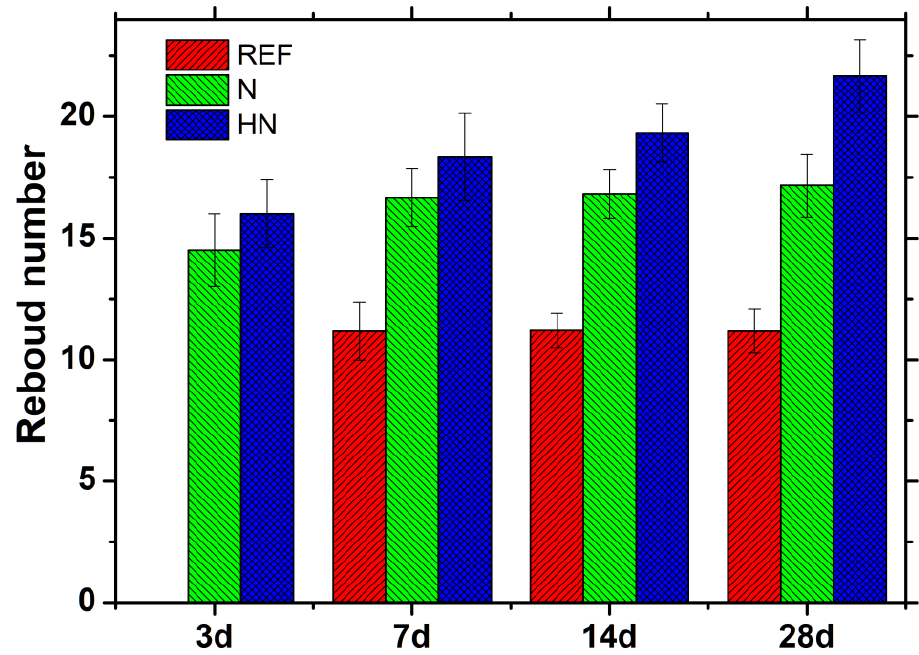
Figure 2. Surface rebound numbers of specimen exposed to seawater.